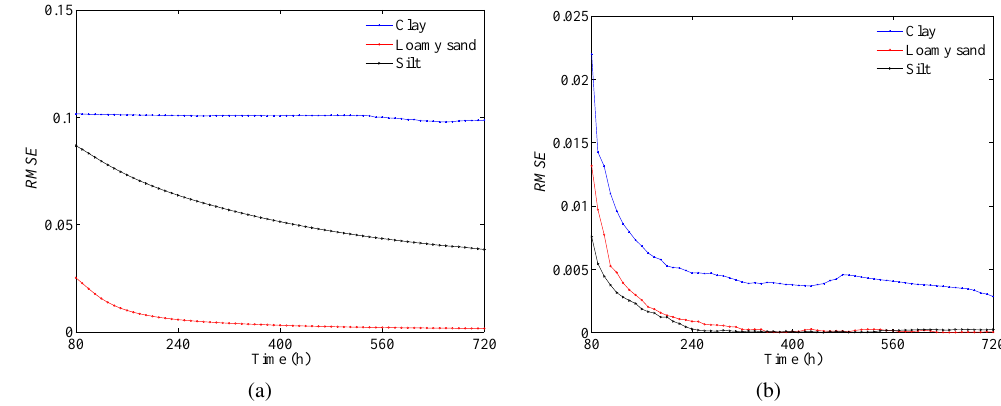
Fig. 6. The RMSE of the open-loop forecast (left) and assimilated (right) soil moisture profiles for clay (blue), loamy sand (red) and silt (black) soils as a function of the simulation time. The update interval is 10 hours.